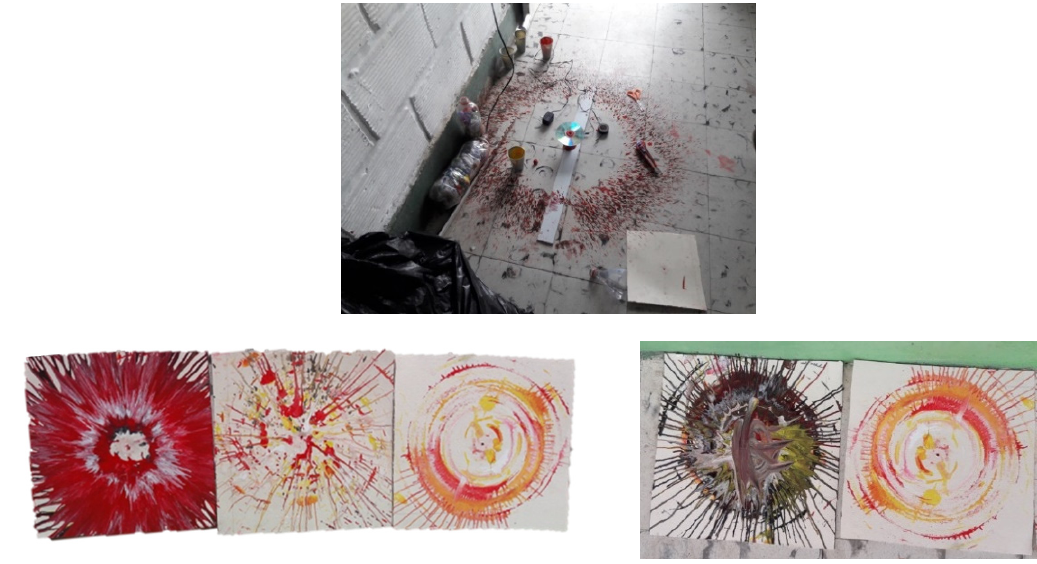
Figure 4. Geometric figures built from proportions as a way of doing art. With this activity, students were able to establish comparisons between figures through their measurements and proportions.